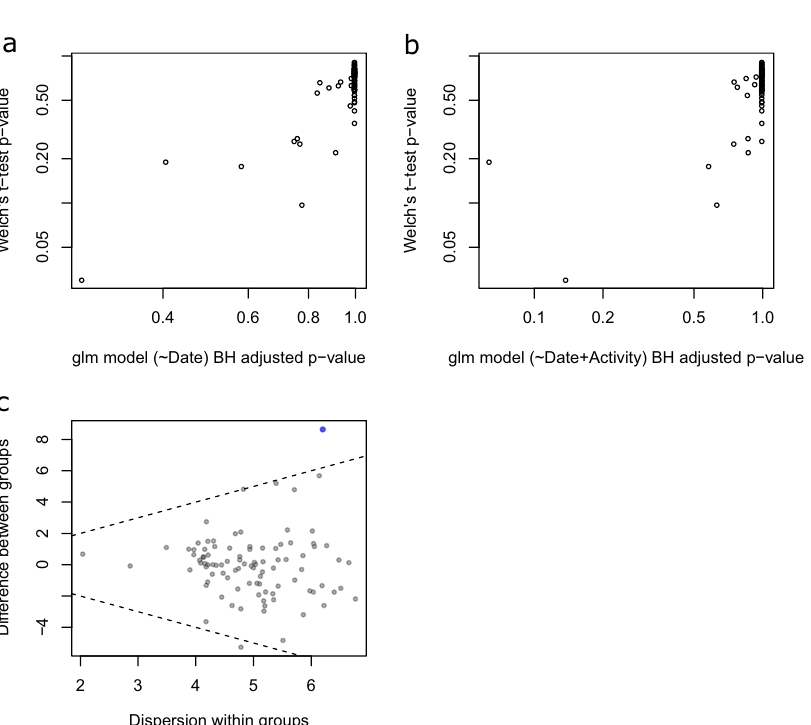
Fig. 4 Differential abundance analysis (ALDEx2) of rectal microbiota in FPS puppies on Days 1 and 8 post-partum. Comparing the glm and t -test. Plots of the expected P values for variables output from the glm function with model. a Day postpartum as a fi xed predictor and model; b with activity scale as a random effect predictor compared to the P values output by the Welch ’ s t -test. All values are the expected value of the test statistic after correction for multiple hypothesis testing; c effect size plot indicating between group difference ( Y axis) and within group dispersion ( X axis). Blue represents features called as differentially abundant with p.adj < 0.1. Puppy ID was included as a random factor in all models. See Supplementary Table 3 for taxa information.